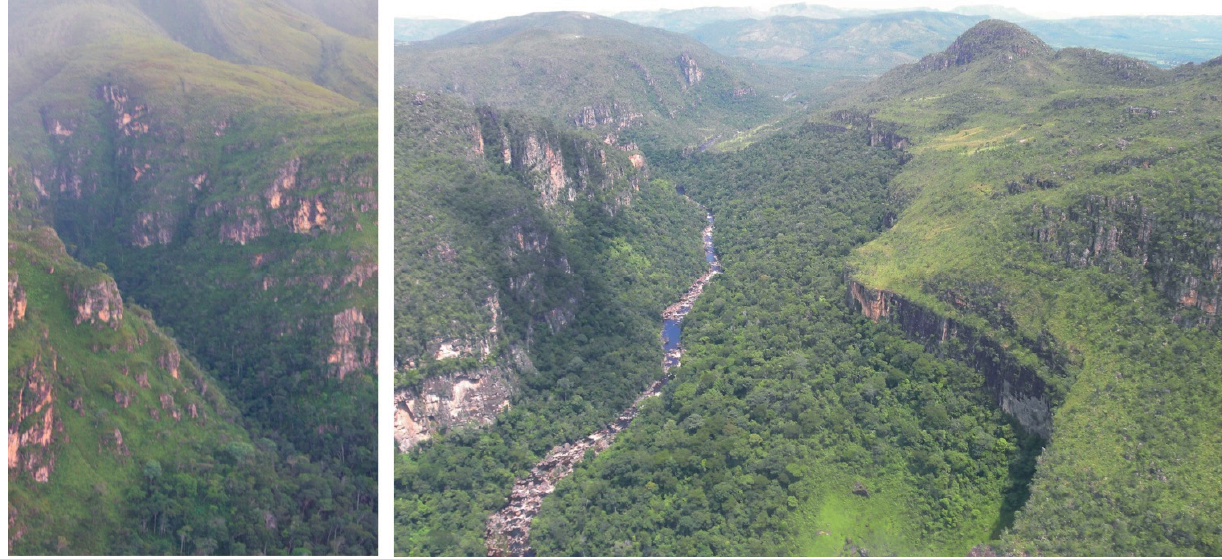
Figure 3. Panoramic photographs of the savanna on rocky outcrops in the Chapada dos Veadeiros National Park.